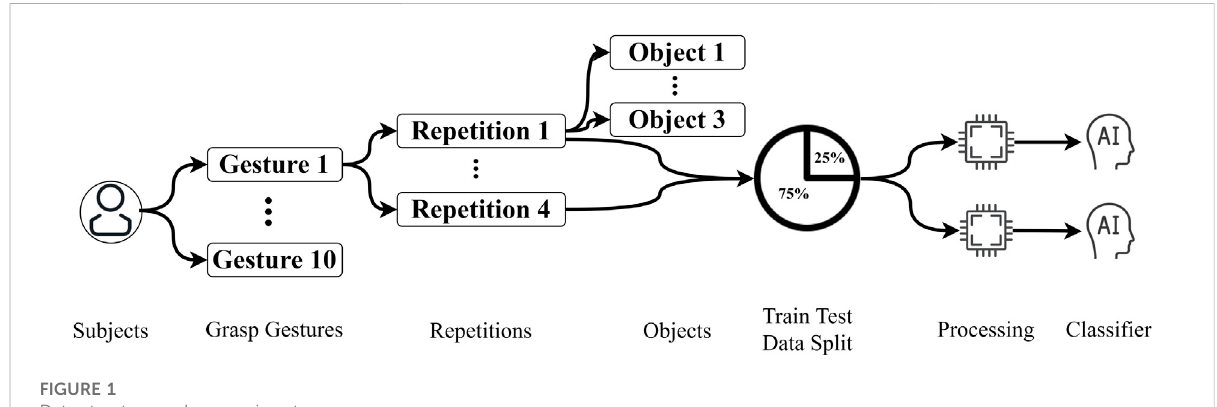
FIGURE 1 Data structure and processing